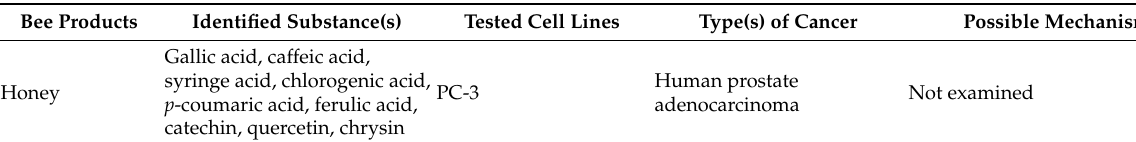
Table 1. Anticancer potentials of selected bee